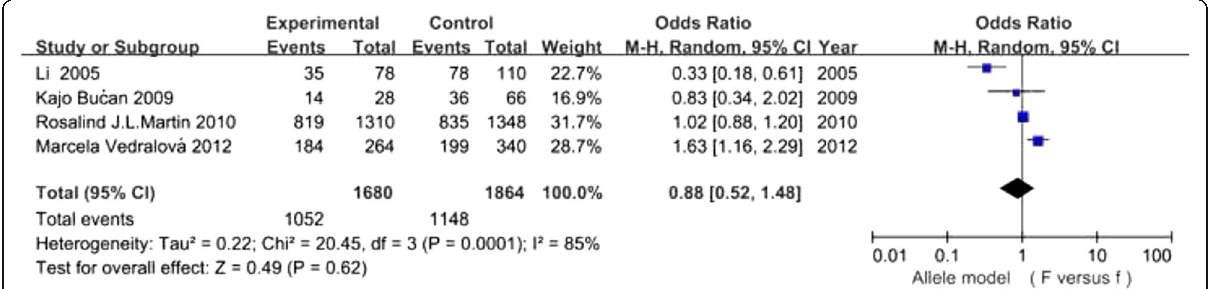
Fig. 3 Association of VDR FokI gene polymorphism(F vs f) with DN susceptibility in overall